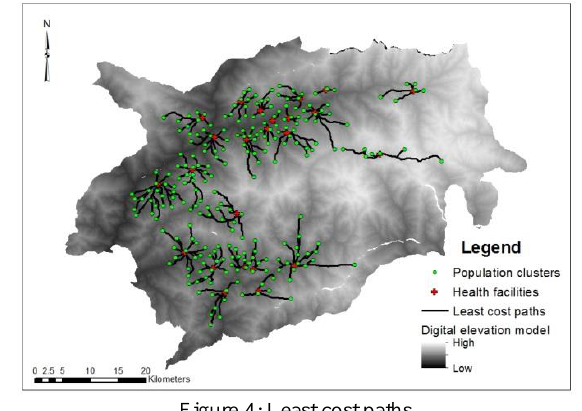
Figure 4: Least cost paths